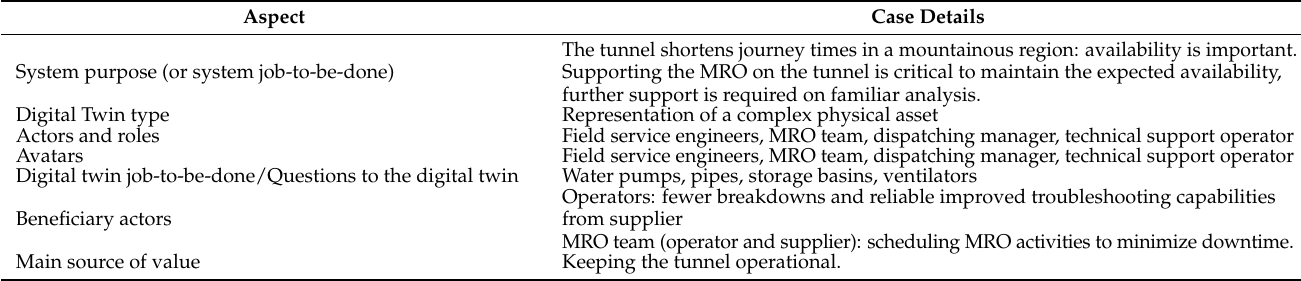
Table A3. Case 1—tunnel maintenance, repair, and overhaul digital twin.